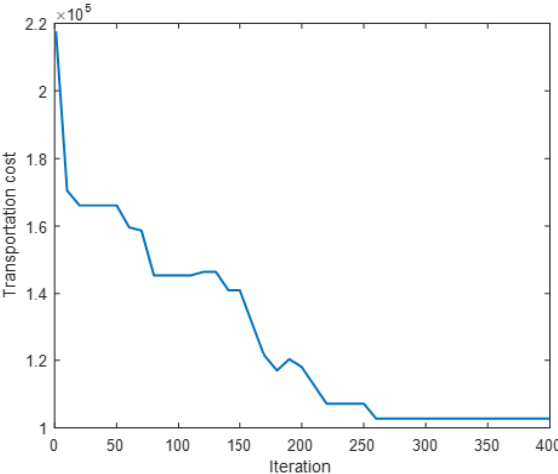
Figure 20. FAGA algorithm cost target iteration curve graph.